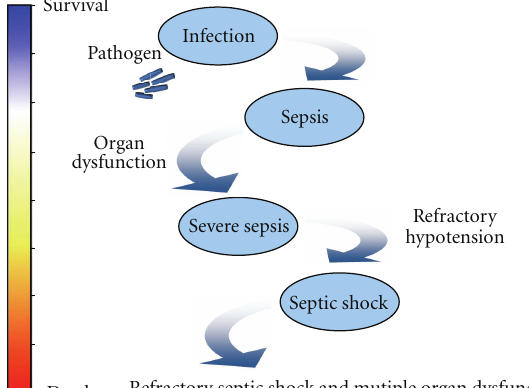
Figure 1: Continuum from infection to septic shock: the initial response to pathogen is a systemic response, with release of in- flammatory mediators and activation of the coagulation cascade, resulting in imbalance between oxygen delivery and oxygen con- sumption. Ultimately, tissue hypoxia develops and may lead to multiple organ dysfunction and irreversible